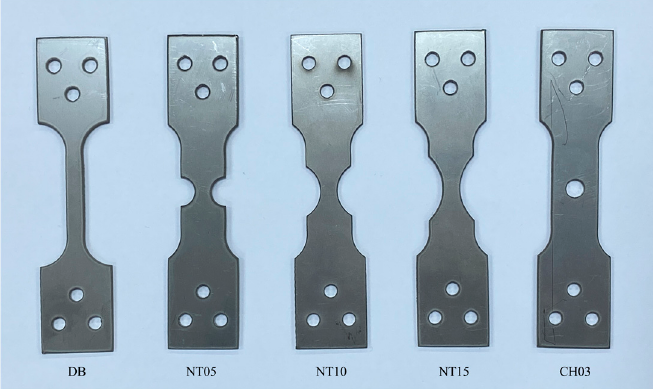
Figure 2. Material test specimens of 304L stainless steel sheet. DB specimen is used to acquire flow stress of 304L stainless steel, which has 6 mm width and 30 mm the length of reduced area. Other specimens are to identify the fracture strain. NT specimens have the radius of curvature of the notch to obtain high-stress triaxiality. The CH specimen has a radius of curvature of 3 mm in the center hole.